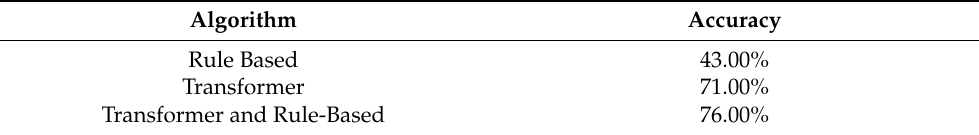
Table 1. Comparison of the matching accuracy achieved by rule-based algorithm, transformer, and their